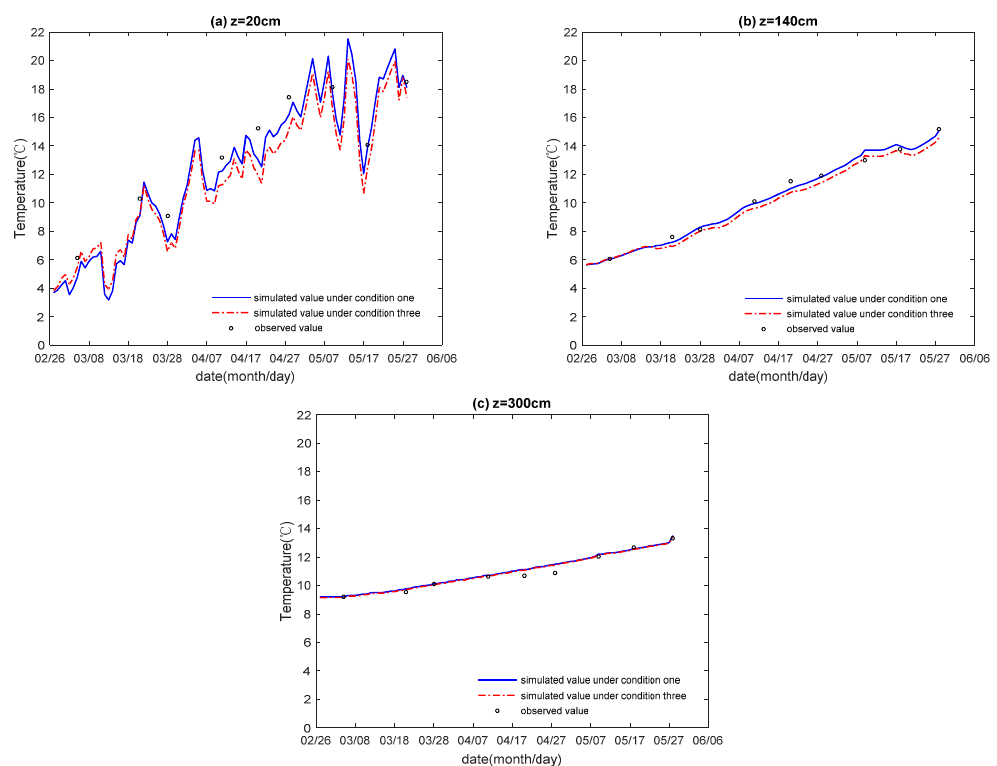
Figure 9. Comparison between simulated and observed values for soil temperature with time at different soil depths under conditions one and three.